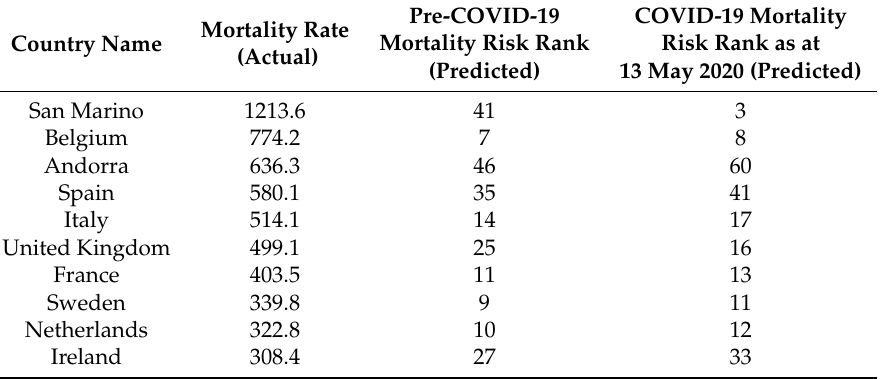
Table 3. Top 10 countries ranked on actual mortality rate and their predicted risk